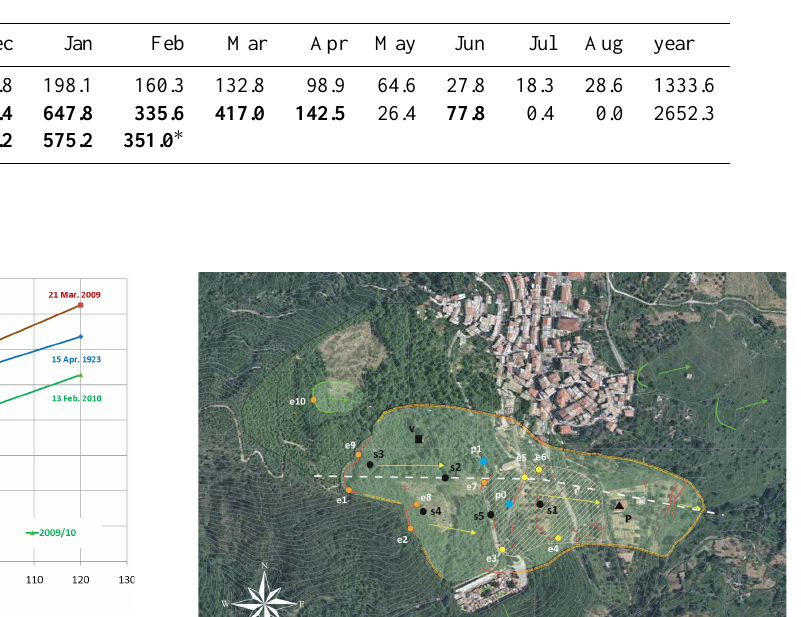
Table 1. Montalto Uffugo rain gauge (468m a.s.l.). First row: 1921–2006 average values (mm); second row: 2008/09 values (mm); third row: autumn-winter 2009/10 values (mm). In bold, values greater than monthly averages.